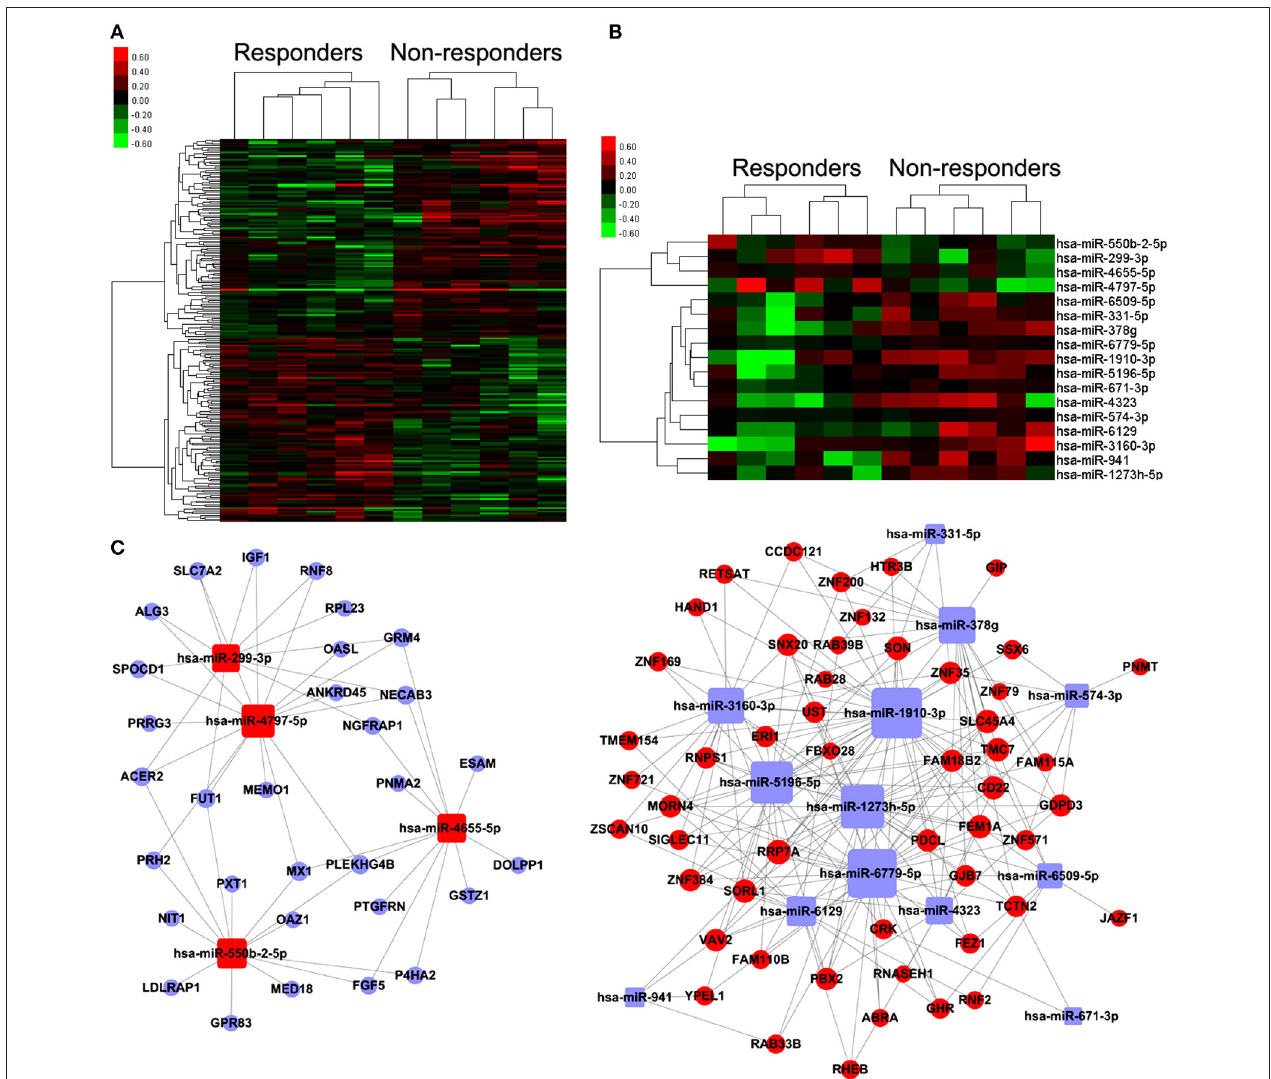
FIGURE 2 | Differentially expressed mRNAs and miRNAs, and miRNA-mRNA coexpression network associated with response to TG tablets. (A,B) Heat map showing hierarchical clustering of mRNAs and miRNAs, whose expression changes were more than 1.5-fold in the comparison between the responder and non-responder groups. In clustering analysis, up- and down-regulated genes are colored in red and green, respectively. (C) miRNA-target gene co-expression network constructed using the differentially expressed miRNAs and their corresponding putative targets which were also distinctly expressed between the responder and non-responder groups. Red and blue square nodes respectively refer to the upregulated and downregulated miRNAs in the responder group compared to the non-responder group. Red and blue circle nodes respectively refer to the upregulated and downregulated mRNAs in the responder group compared to the non-responder group. The sizes of the nodes were represented by degree that is the contribution of one miRNA to the genes around or the contribution of one gene to the miRNAs around.